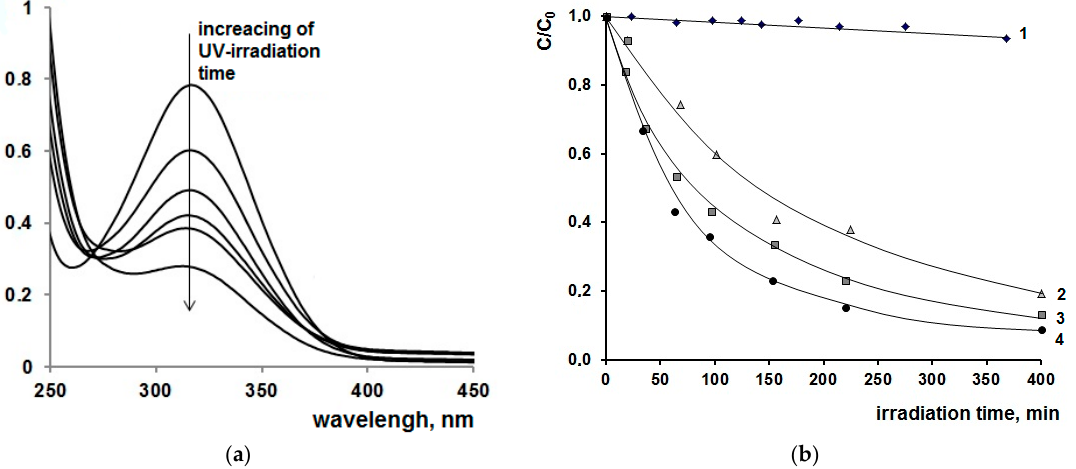
Figure 7. Photocatalytic activity of copolymers under UV irradiation: ( a ) the change of absorption spectrum of p-NP solution in the presence of photocatalyst [( ≡ TiO) n ]:[HEMA]:[M]; ( b ) the change of p-NP concentration in solution: curve 1—«empty» experiment, curve 2—BMA + NPs Ag, curve 3—HEMA + NPs Ag; curve 4—AN + NPs Ag.